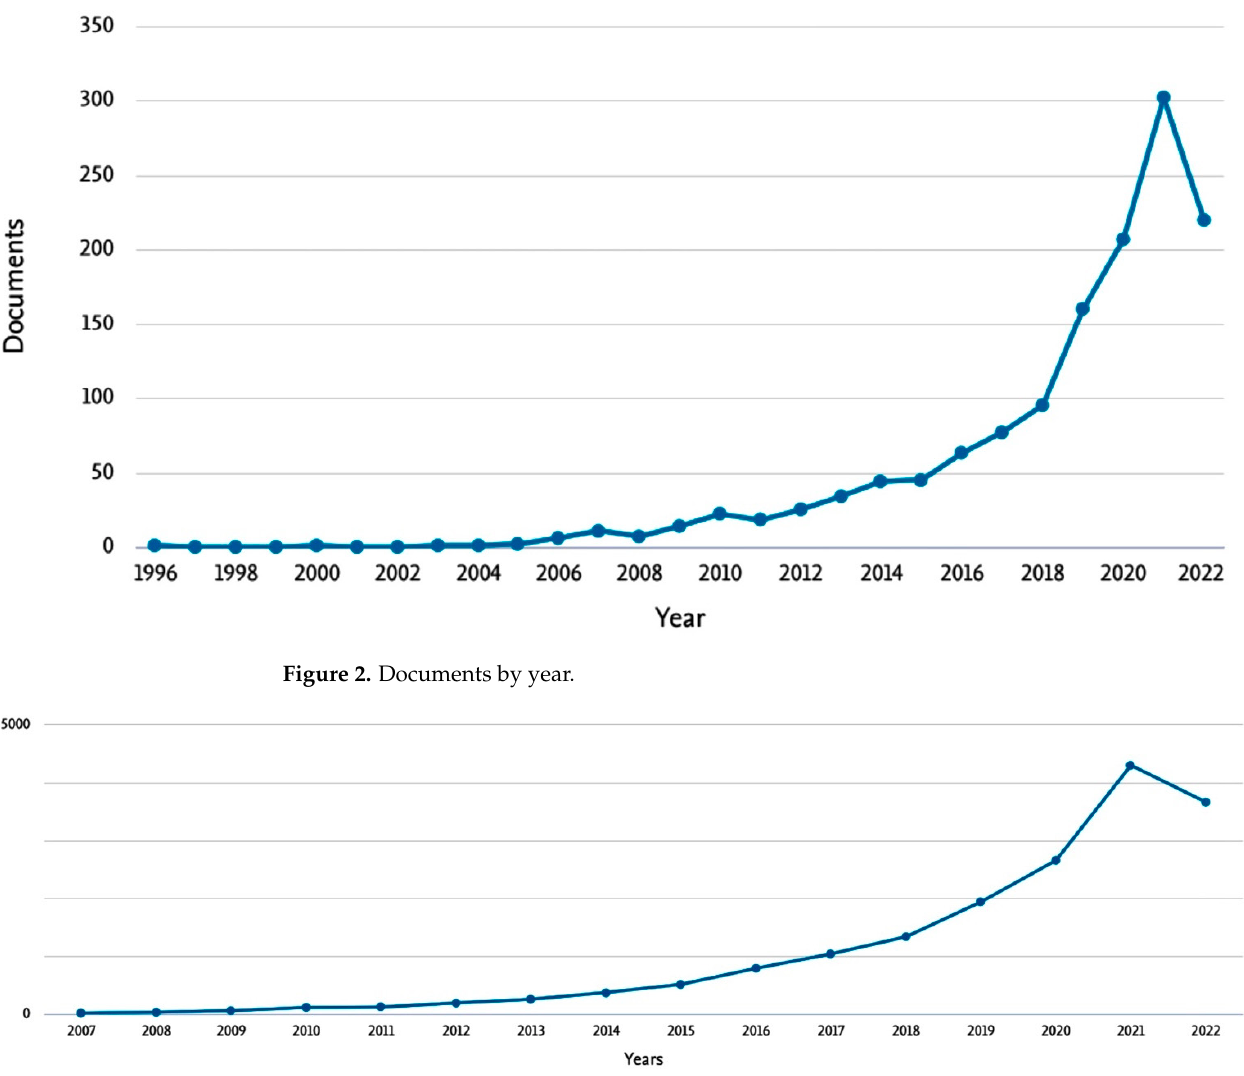
Figure 3. Citations by year.